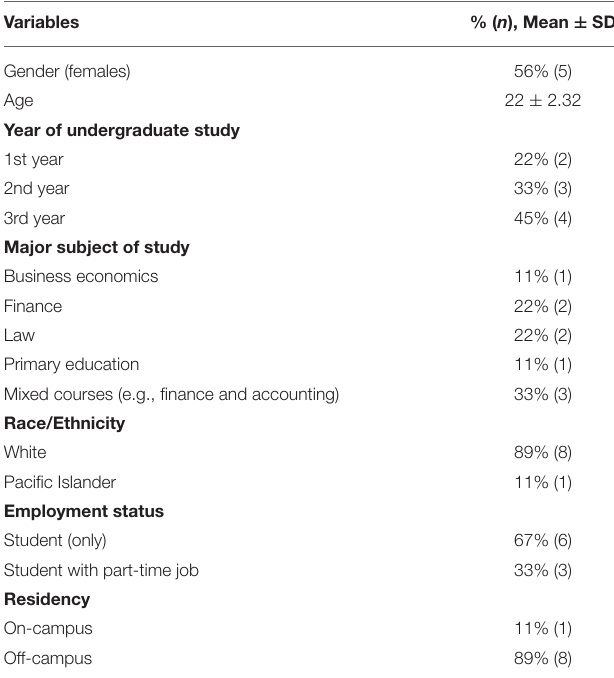
TABLE 3 | Characteristics of participants in the pilot trial and process evaluation ( n = 9).